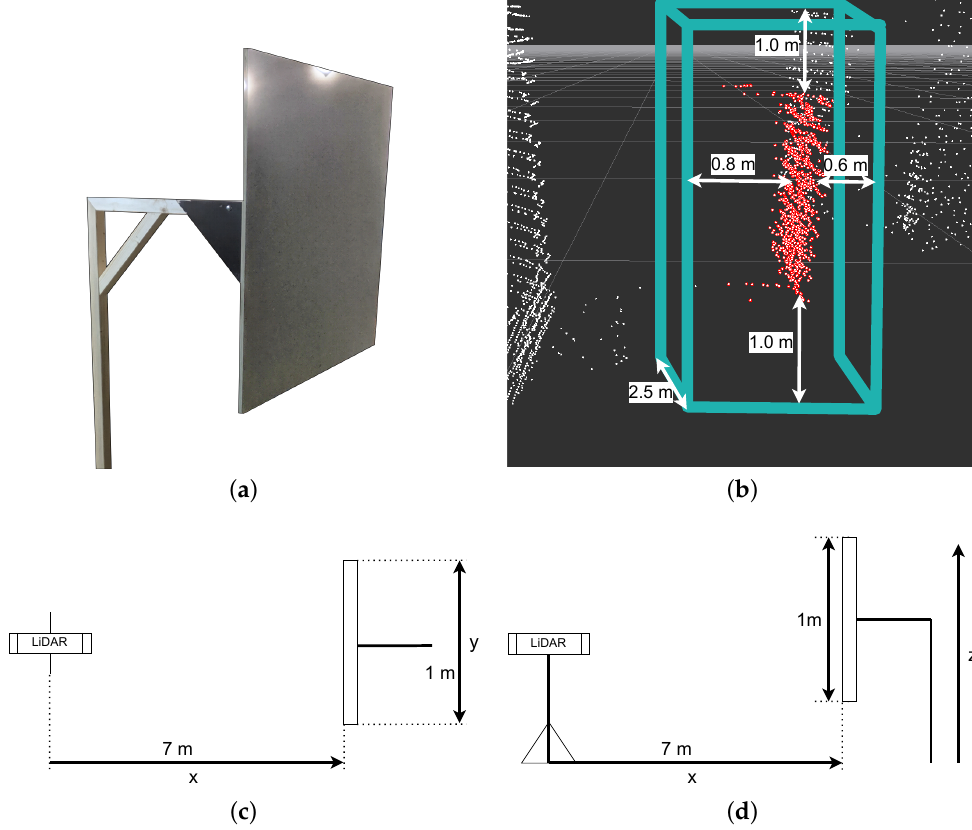
Figure 2. Scenario 2: ( a ) Square meter plane target. ( b ) Point cloud of a detected target. Red points are points left over after cutting out a box around the plane. The box is spaced 1 m below and 1 m above the plane, 60 cm in front and 80 cm behind. It is 2.5m wide around the center of the plane. ( c , d ) Topview and sideview of the measurement